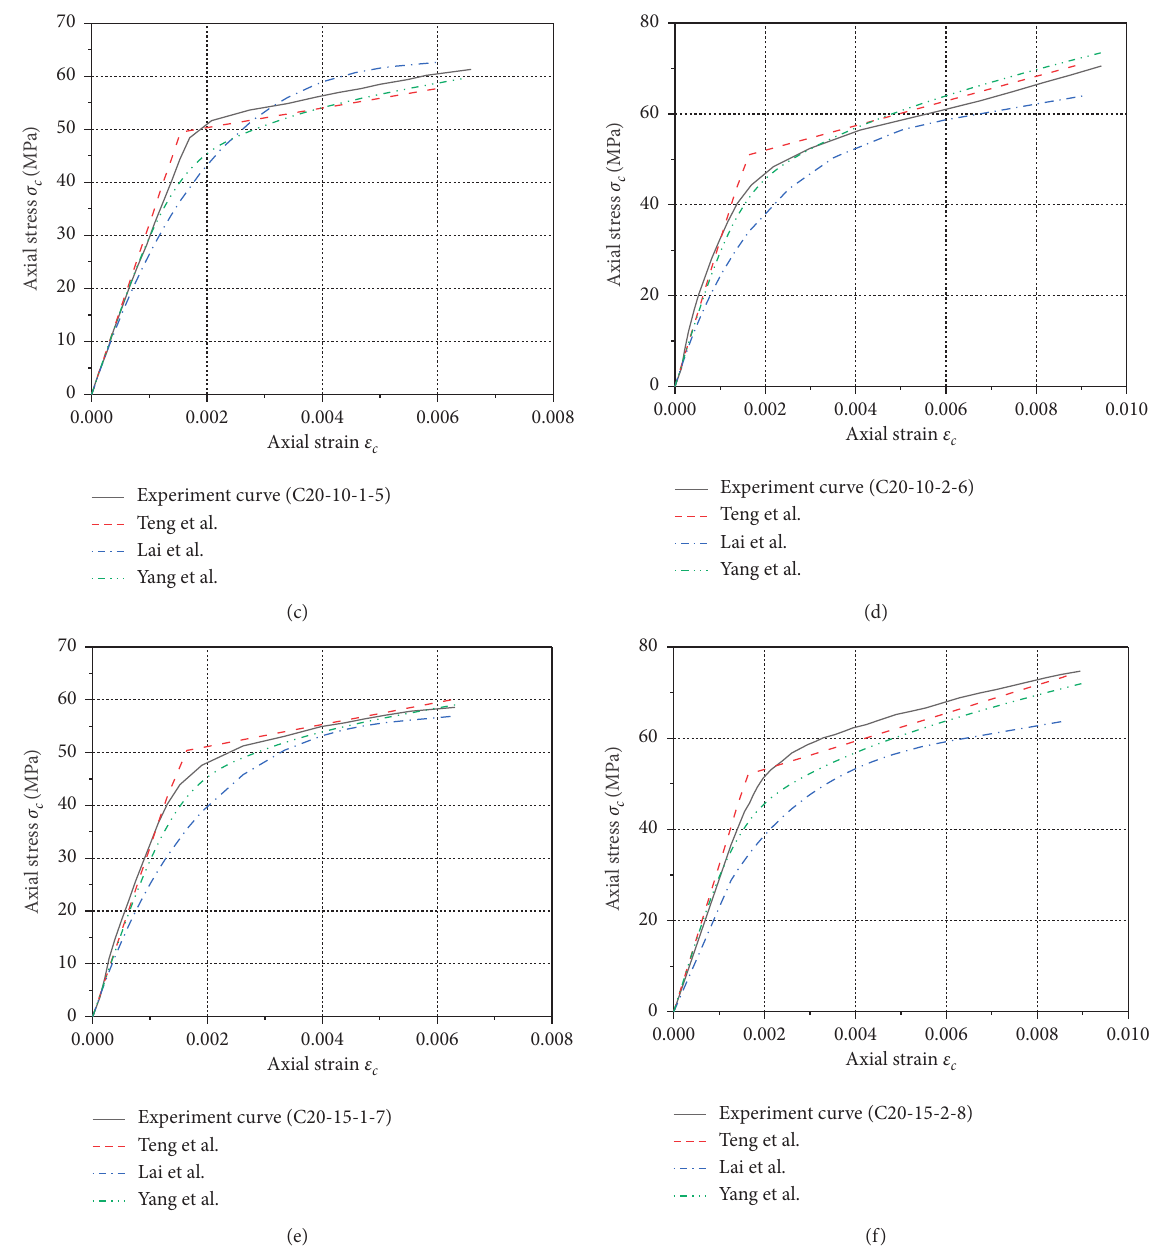
Figure 11: Comparison of calculated stress-strain curves with the experiment curve of group C20. (a) C20-5-1-3. (b) C20-5-2-4. (c) C20-10- 1-5. (d) C20-10-2-6. (e) C20-15-1-7. (f)